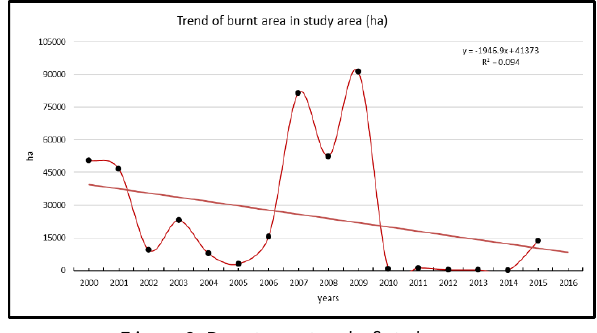
Figure 2. Burnt area trend of study